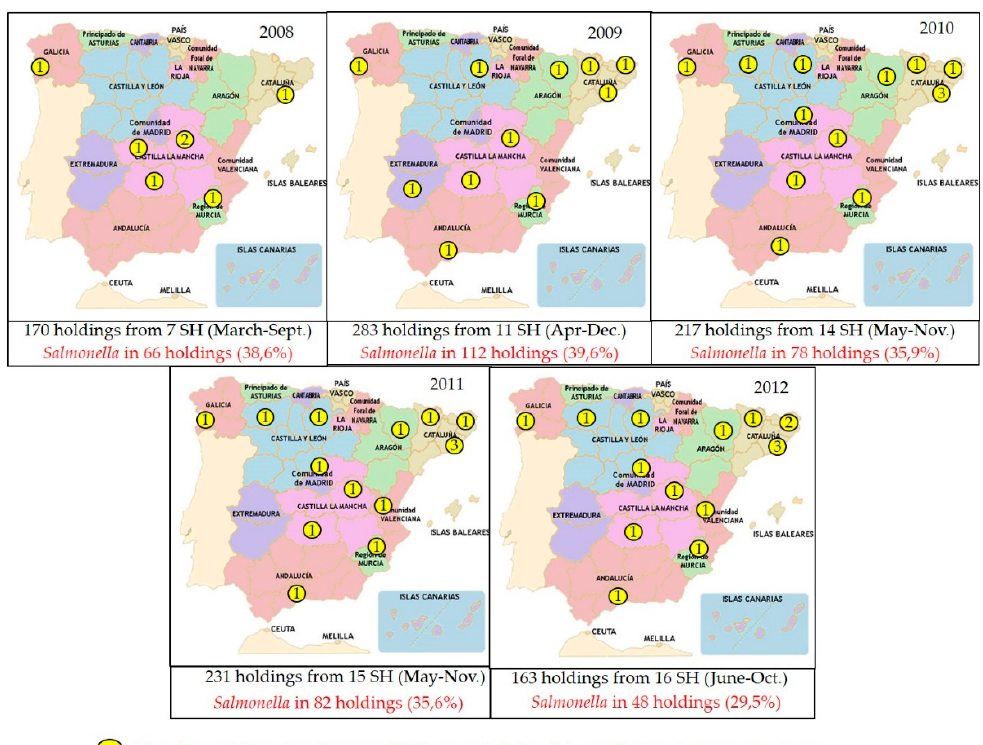
Figure 1. Number and distribution of slaughterhouses sampled and results of the Salmonella annual monitoring program in slaughter pigs in Spain. In black, number of total holdings and slaughterhouses (SH) sampled (time period of sampling). In red, positive (+) results to Salmonella . (Self-creation from the information retrieved from the reports in MAPA website).